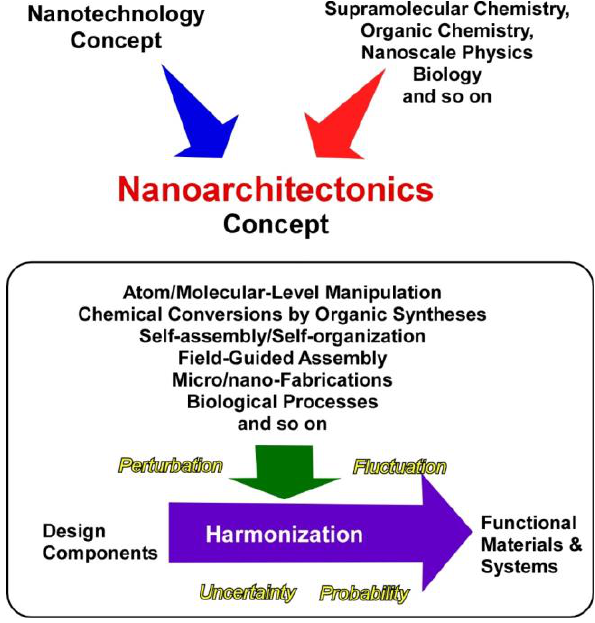
Figure 1. Outline of the nanoarchitectonics concept for the fabrication of functional materials and systems from molecular / nano